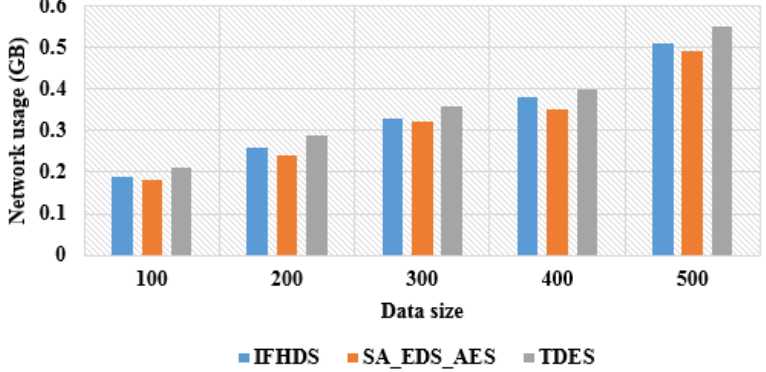
Figure 5. TDES network usage is compared with existing techniques.